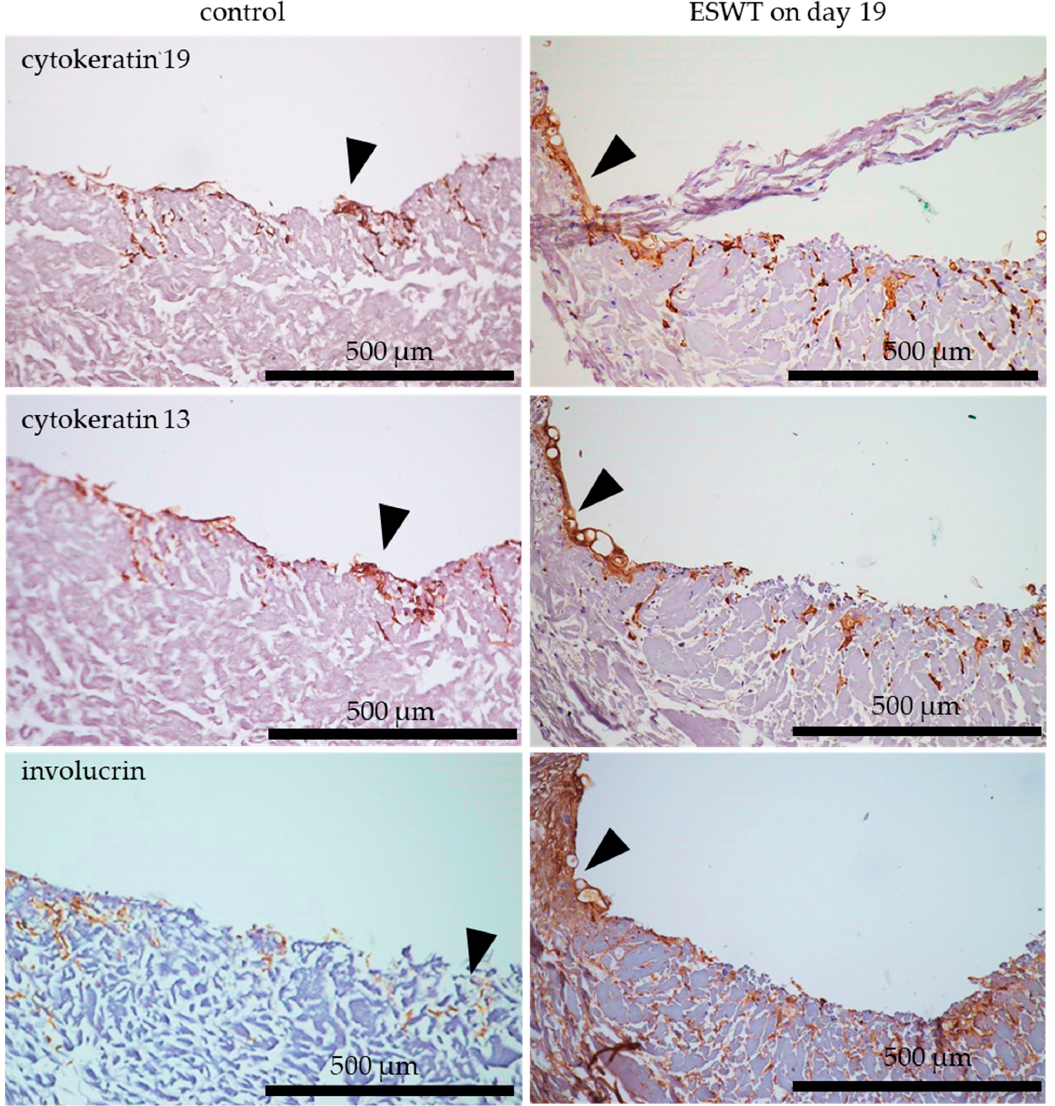
Figure 6. Formation of a multilayered epithelium on culture day 33 of oral mucosa equivalent (tri-culture) in vitro after treatment with ESWT on culture day 19. Untreated tissue equivalents fixed on day 33 served as control. Cytokeratin 19 was used as a marker for undifferentiated basal epithelial cells (arrows), cytokeratin 13 for suprabasally differentiating epithelial cells (arrows), and involucrin for fully differentiated epithelial cells (arrows). The oral mucosa equivalents were analyzed by immunohistochemistry. Consecutive sections from the samples were used for the staining with different antibodies. In the images, the cell occlusive side of the collagen matrix is directed upwards, and the porous side is directed downwards. Scale bars represent 500 μ m.